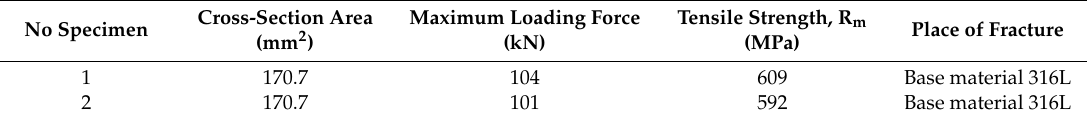
Figure 3. View of the specimens after a static tensile test: ( a ) specimen A and ( b ) specimen B. Welds marked by dashed contour lines. Table 3. Tensile test results of welded joints.